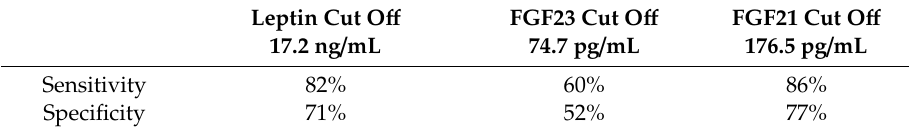
Figure 6. The receiver operating characteristic curves for proteins depending on the grading of endometrial cancer. Table 6. Sensitivity and specificity of individual proteins.